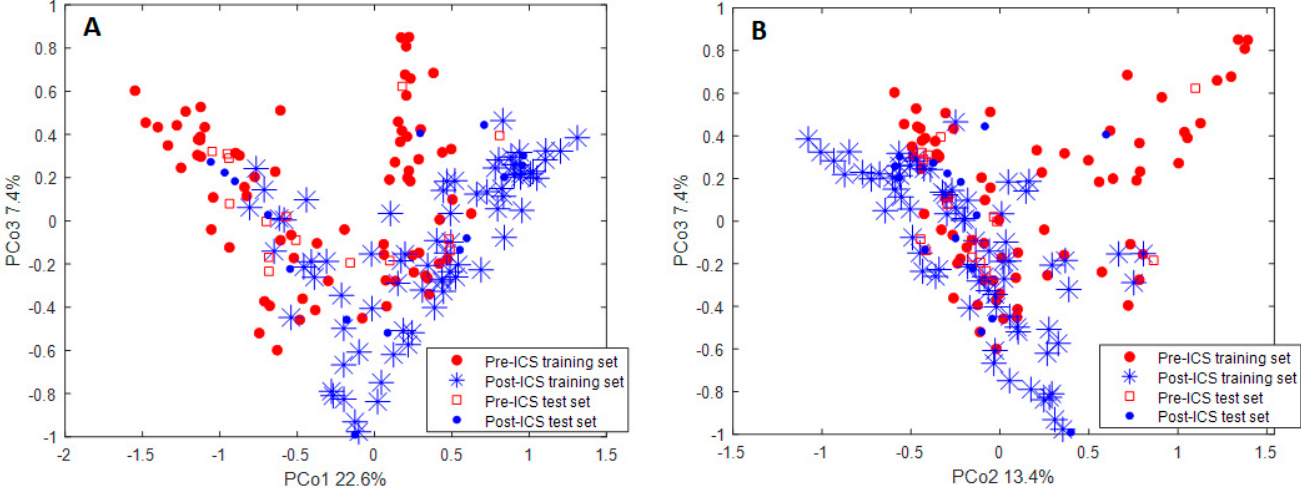
Figure 3. Principal Coordinate Analysis score plot for ( A ) PCo1 and PCo3, and ( B ) PCo2 and PCo3 on a proximity matrix obtained from the Random Forest model performed on the training set and 20 of the most discriminatory volatile organic compounds. The test set was projected into the space defined by the training samples. Every point belongs to a single breath fingerprint (blue stars: post- ICS training set; red circles: pre-ICS training set; blue circles: post-ICS test set; red squares: pre-ICS test set). The separation is observed on Principle Component 1, explaining 22.6% of the variance. PCo: Principal Coordinate; ICS: inhaled corticosteroids.